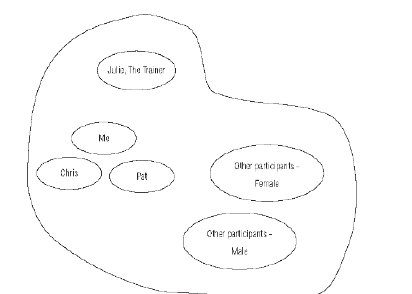
Figure 12: Anticipatory Group Imago (Hay, 2009 p.171)